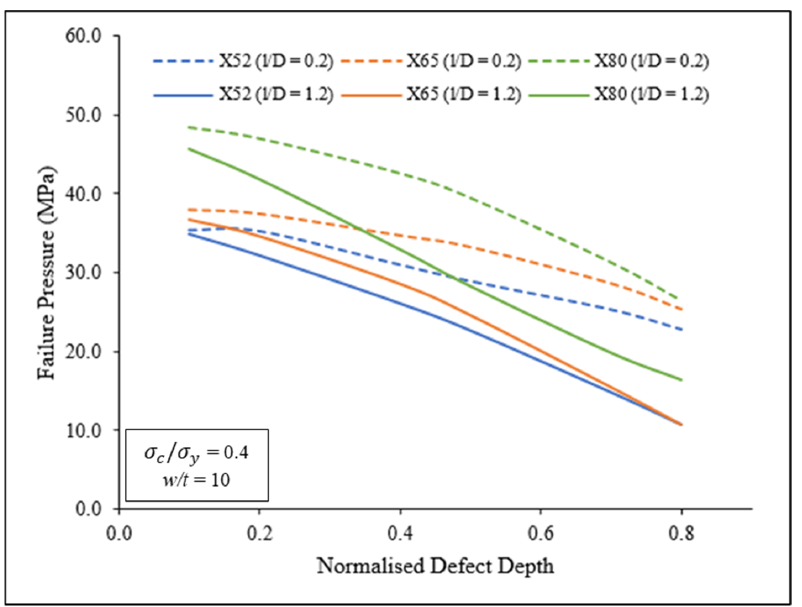
Figure 9. Failure pressure against normalised defect depth, with 0.0 and 0.7 normalised longitudinal compressive stresses for X52, X65, and X80.